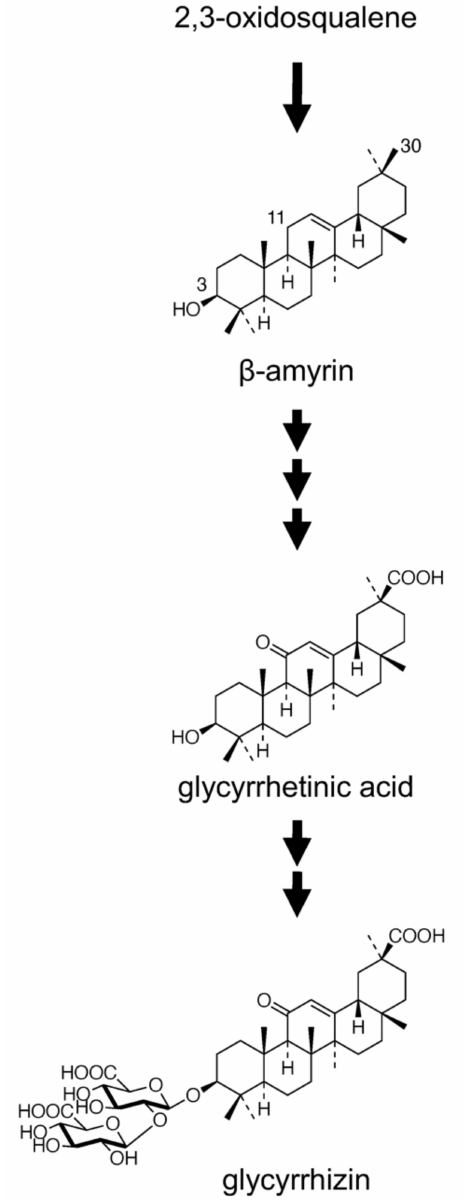
Figure 1. Proposed glycyrrhizin biosynthetic